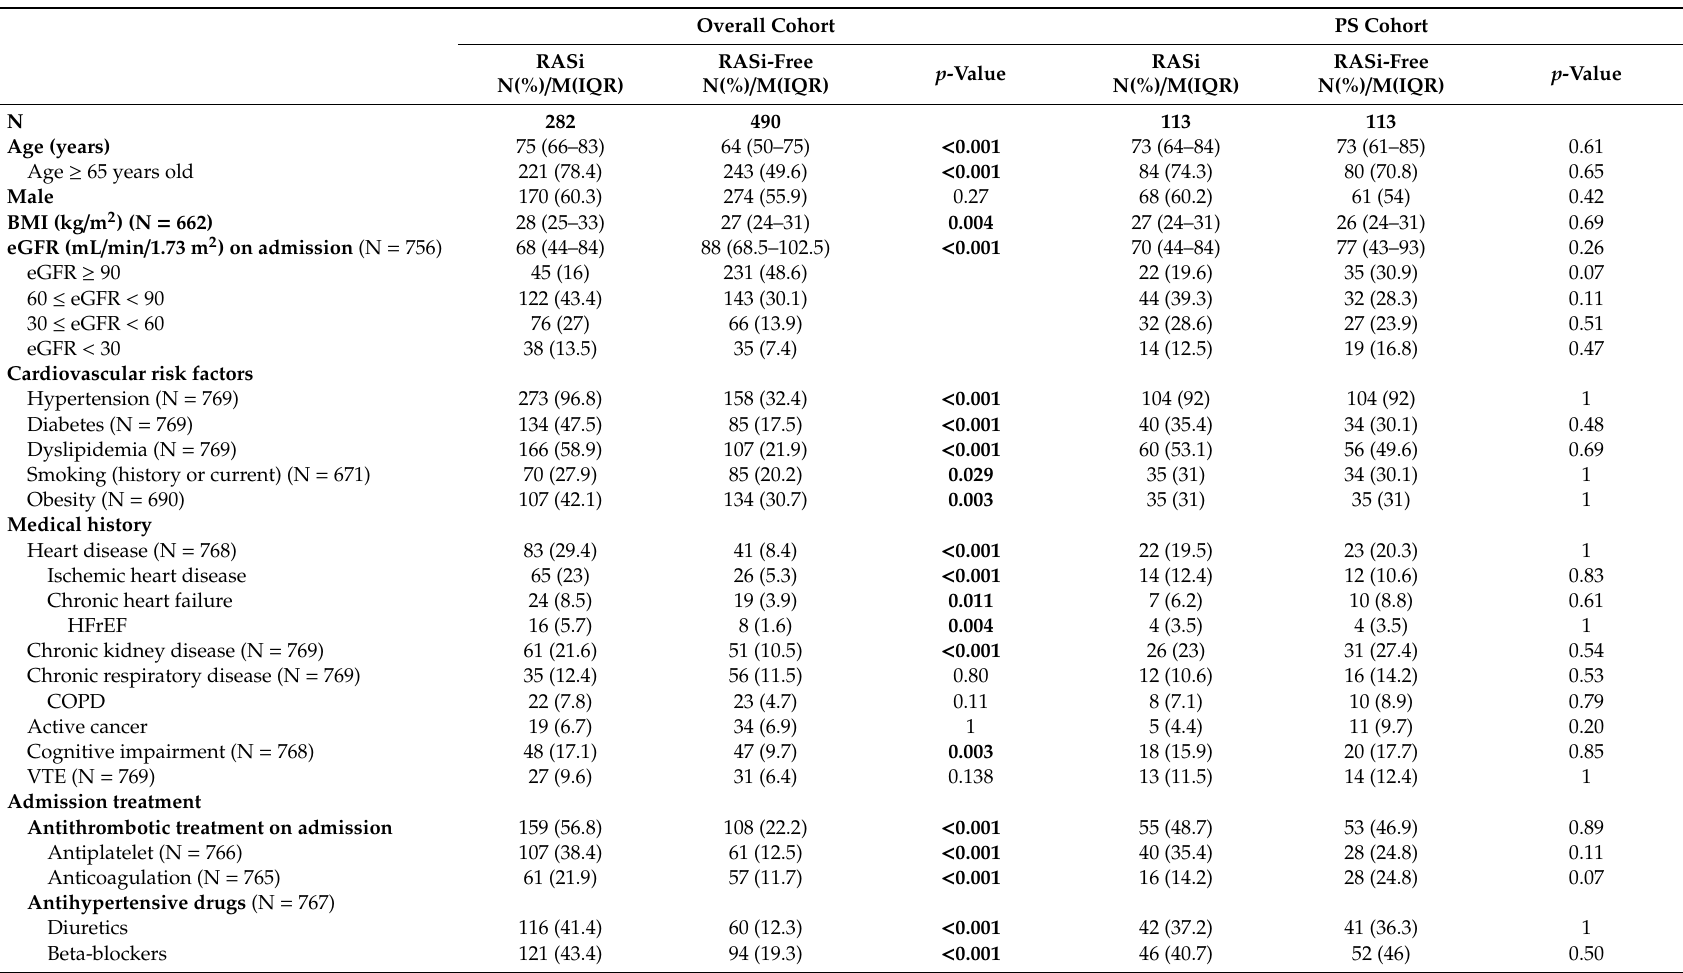
Table 1. Baseline demographics and clinical characteristics of the overall cohort and the propensity score-matched population according to previous RASi